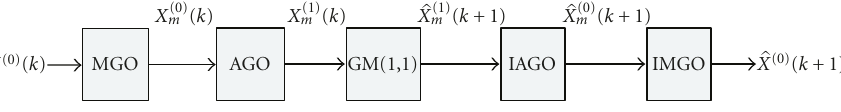
Figure 5: The procedure of grey prediction with